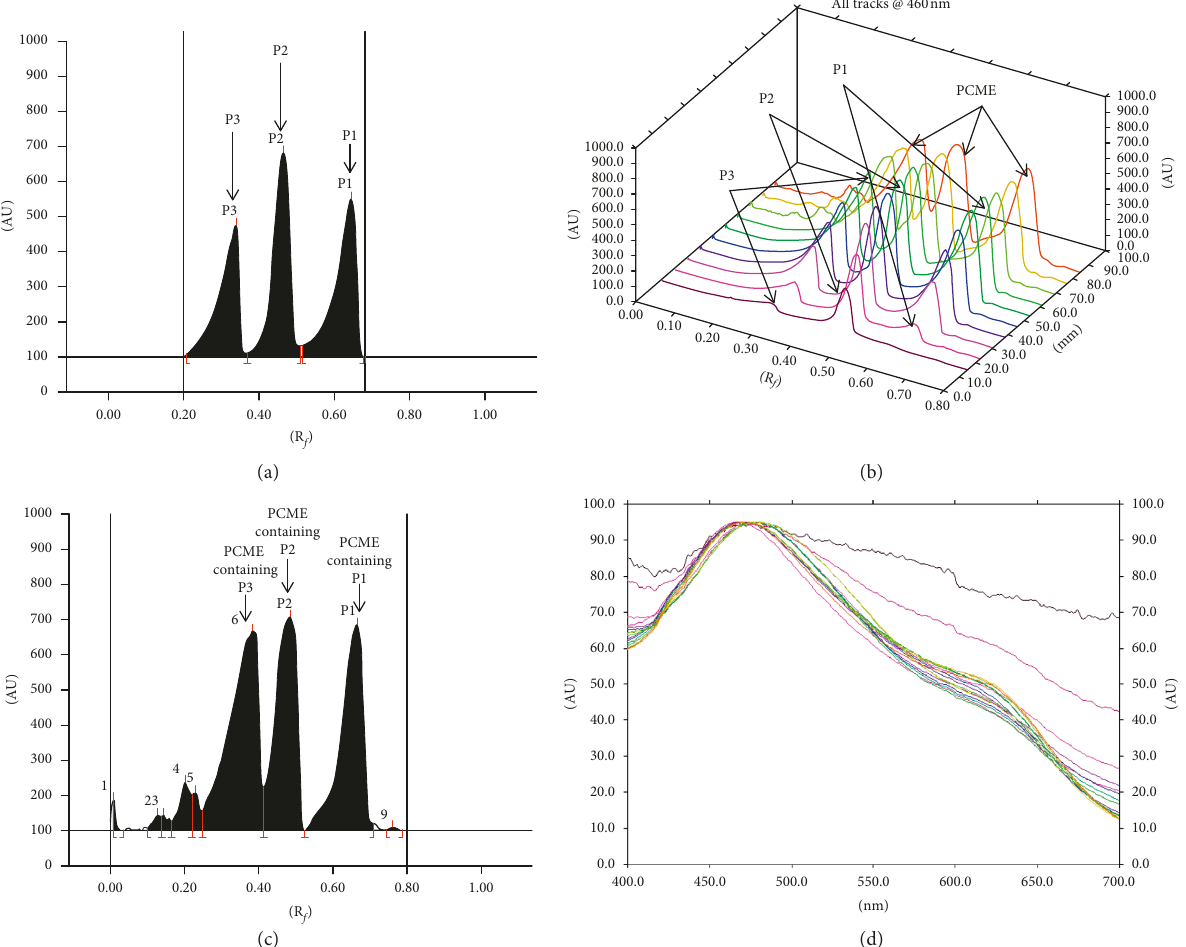
Figure 2: Quantification of P1 , P2 , and P3 in PCME by HPTLC at λ 9.5: 0.5)). (a) Chromatogram of standard P3 ( R f PCME ( P3 , spot 6, R f